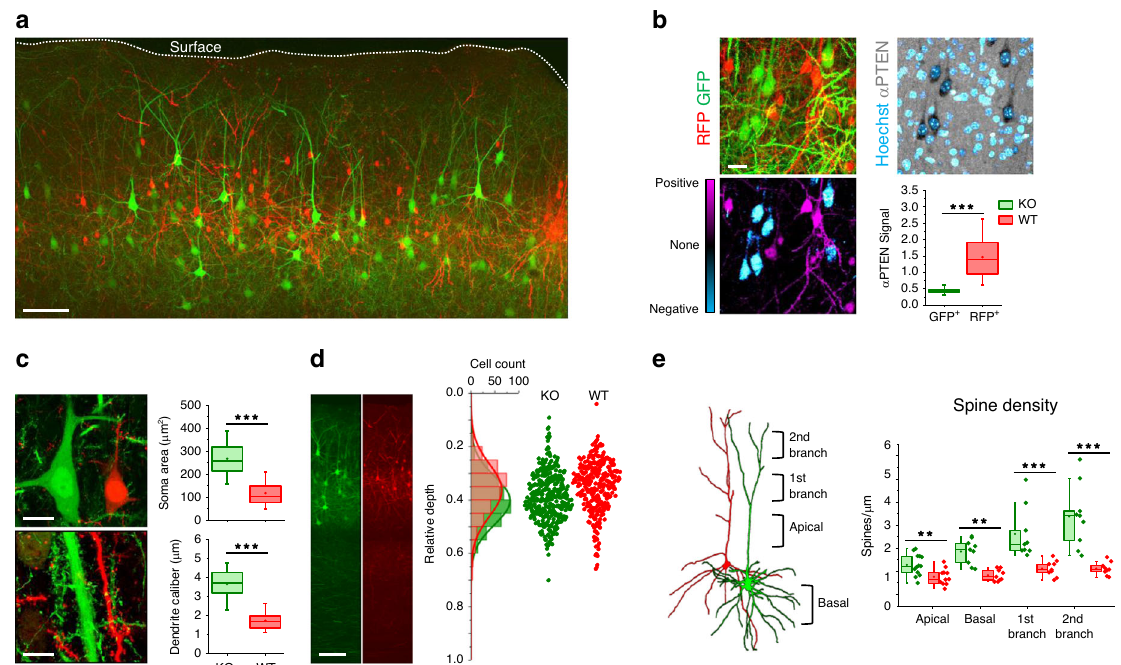
Fig. 4 Beatrix-induced mosaic in a Pten fl ox conditional mouse. a Maximum intensity projection of a Pten fl ox KO mosaic in mouse cortex. Scale bar 100 µ m. b The lack of PTEN was con fi rmed by performing immunostaining against PTEN in the cortex mosaic. The colocalization analysis between Beatrix reporters and PTEN immuno fl uorescence highlights the absolute reliability of the system as a reporter of the genomic status. This is con fi rmed by the quanti fi cation of immunostaining signal in RFP/GFP positive cells ( n = 3 mice; 169, 136 cells; two-sided Mann – Whitney U test, *** p < 0.001). Boxes indicate the 25 and 75 percentiles, means and medians are indicated by dots and lines respectively, whiskers indicate the 5 and 95 percentiles. Scale bar 20 µ m. c Structural details from PTEN knockout mosaics showing that the loss of PTEN causes hypertrophy of both somata and dendrites of cortical pyramidal neurons ( n = 203, 159 cells; two-sided Mann – Whitney U test, *** p < 0.001; no adjustments were made for multiple comparisons). Scale bar 10 µ m. d The distribution of the relative depth of neurons shows that the embryonic deletion of PTEN causes a defective migration following neurogenesis, since KO cells show a larger dispersion between the cortical layers. Scale bar 100 µ m. e Spine density was quanti fi ed in different cellular compartments, highlighting a strong increase in spinogenesis, especially in the apical compartment ( n = 3 mice, two-sided Mann – Whitney U test, ** p < 0.01, *** p < 0.001; no adjustments were made for multiple comparisons). In ( b , c , e ) data are represented as box plots (see the section Statistics and reproducibility in “ Methods ” for a detailed